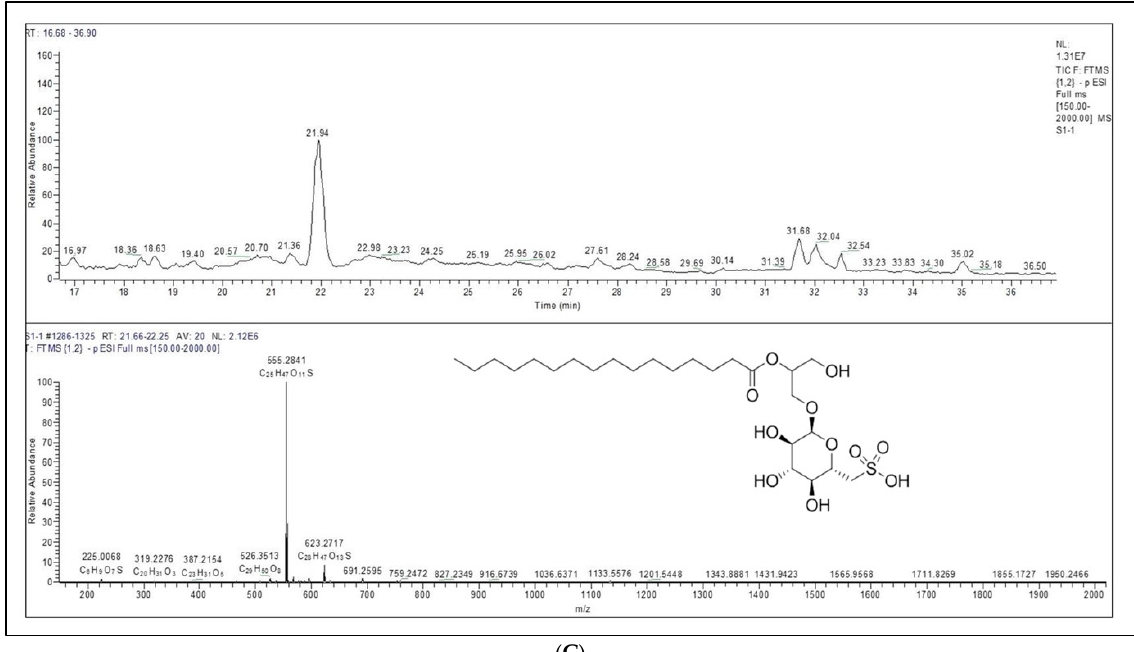
Figure 6. Total ion chromatogram of the D. setosum extract of an ion peak at m / z . ( A ) 189.1492 [M + H] + matched the molecular formula C 10 H 20 O 3 , putatively identified as 8-Decene-1,3,5-triol, ( B ) 203.1648 [M + H] + matched the molecular formula C 11 H 22 O 3 , putatively identified as 3-Hydroxyundecanoic acid and ( C ) 556.2841 [M + H] + matched the molecular formula C 25 H 48 O 11 S, putatively identified as 1- O -(6-Deoxy-6-sulfoglucopyranosyl) glycerol; α - D -form, 3-Hexadecanoyl. RT: retention time; E0: 1.0 × 10 0 ; E5: 1.0 × 10 5 ; E6: 1.0 × 10 6 ; E7: 1.0 × 10 7 .